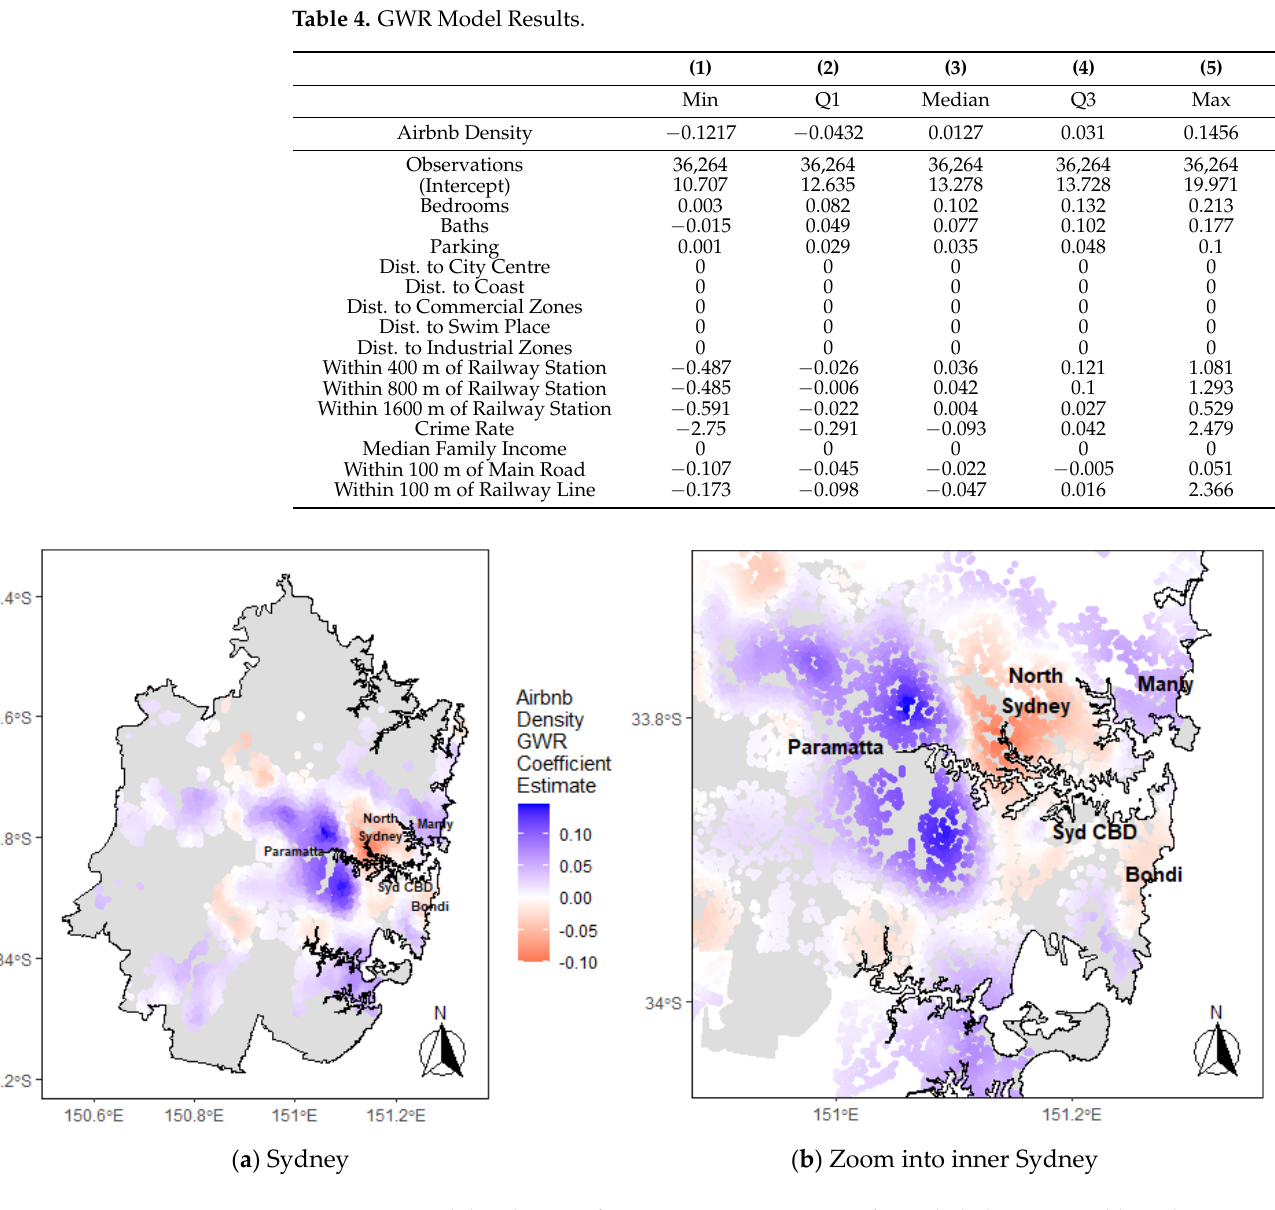
Figure 2. Spatial distribution of GWR parameter estimates for Airbnb density variable with 190 nearest neighbours.